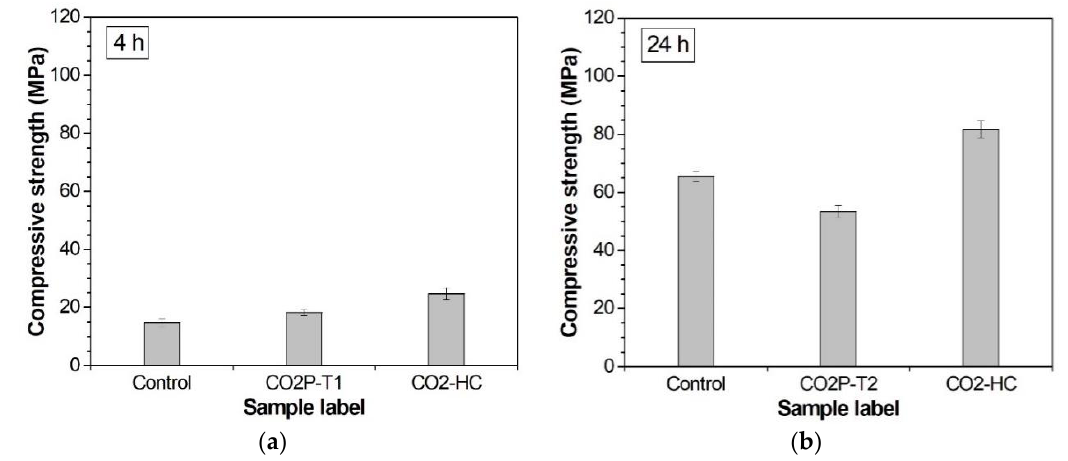
Figure 2. Compressive strengths at 4 h ( a ) and 24 h ( b ).